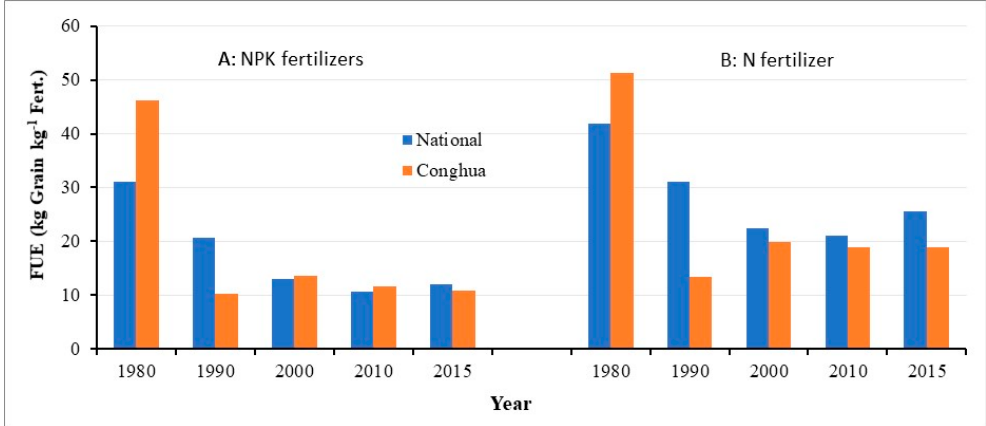
Figure 2. Fertilizer use e ffi ciency (FUE) and nitrogen fertilizer use e ffi ciency (NUE) of paddy rice in the study area and China for selected years (( A ): Based on the equivalent pure N estimated from all N, P, and K fertilizers applied in paddy fields; ( B ): Based on the pure N from the nitrogen fertilizers only applied in paddy fields) [28].